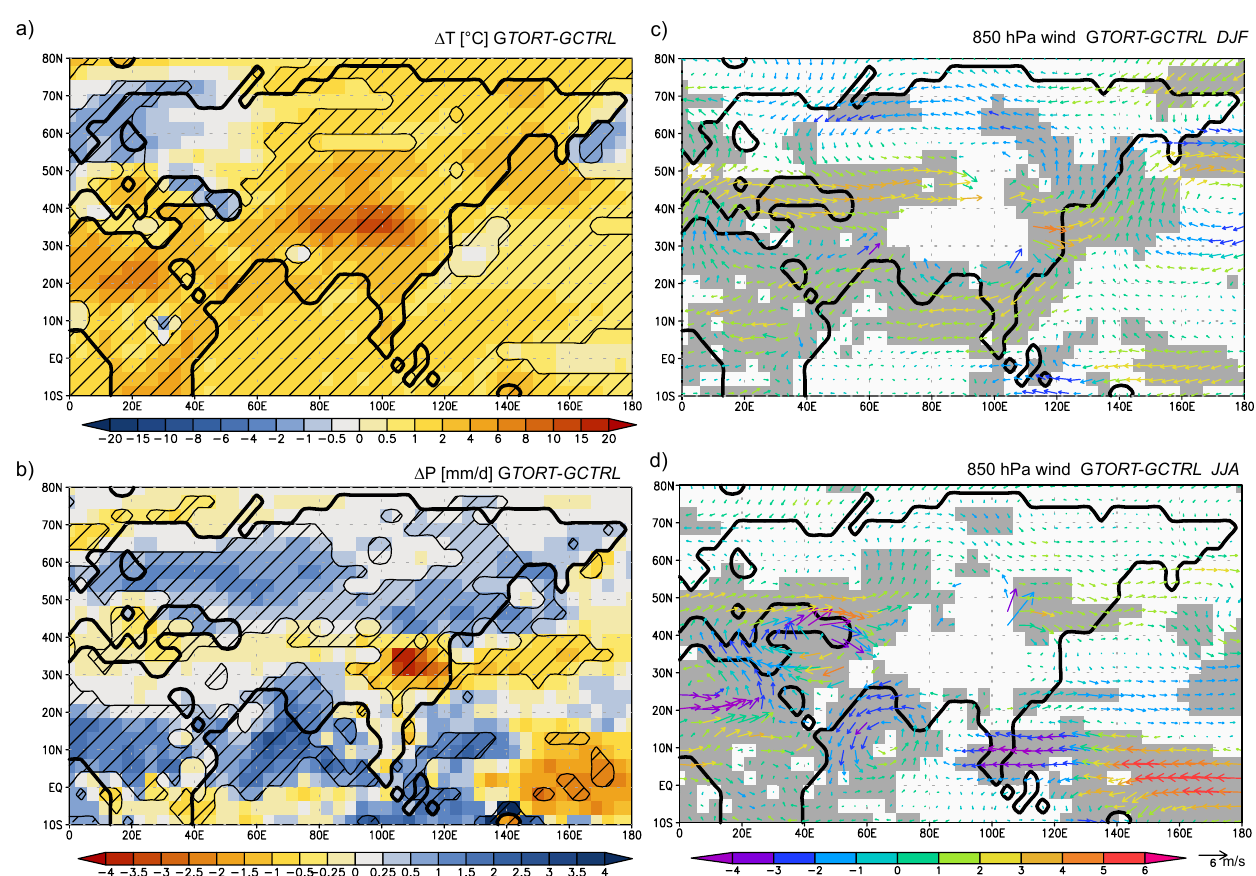
Fig. 2. The annual average difference for temperature ( ◦ C) (a) and precipitation (mmd − 1 ) (b) , and the wind anomalies (ms − 1 ) at 850hPa for winter (DJF) (c) and summer (JJA) (d) between the Tortonian (GTORT) and the present-day control (GCTRL) run of the global model. The hatched areas in (a, b) and the shaded areas in (c, d) show the significant anomalies with a Student’s t-test ( p = 0 . 05). The colour of vectors in (c, d) denotes the changes in wind speed.